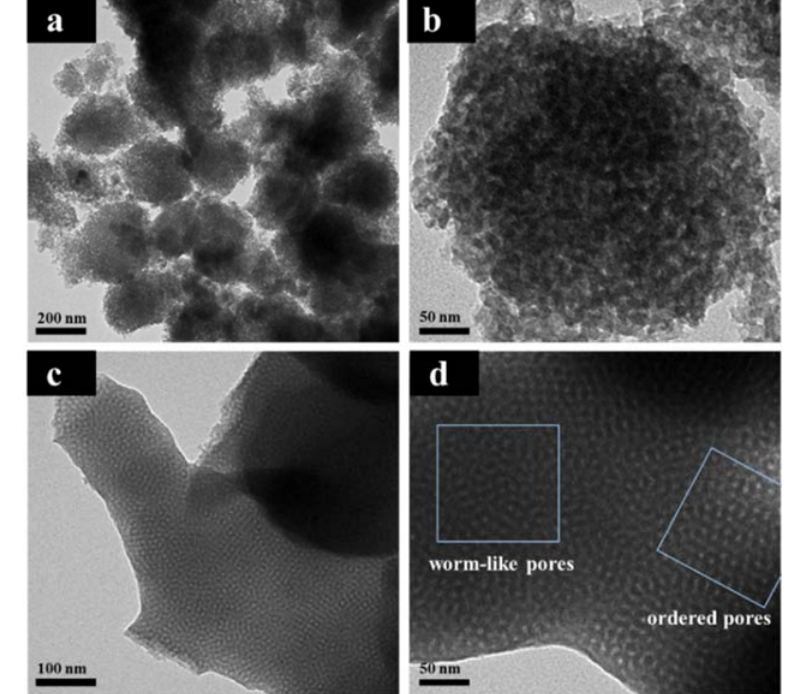
Figure 3. TEM images of NMC ( a , b ) and Mg-NMC ( c , d ).